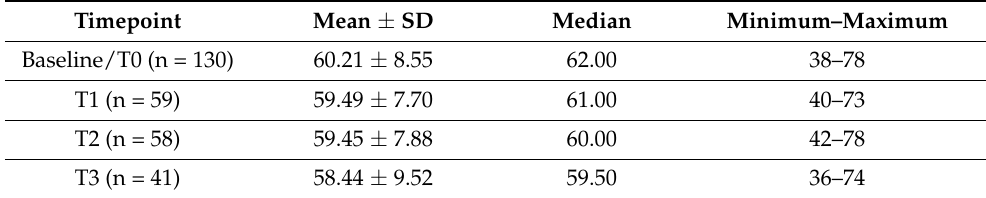
Table 2. Descriptive statistics for HIT-6 total disability score by survey timepoint.